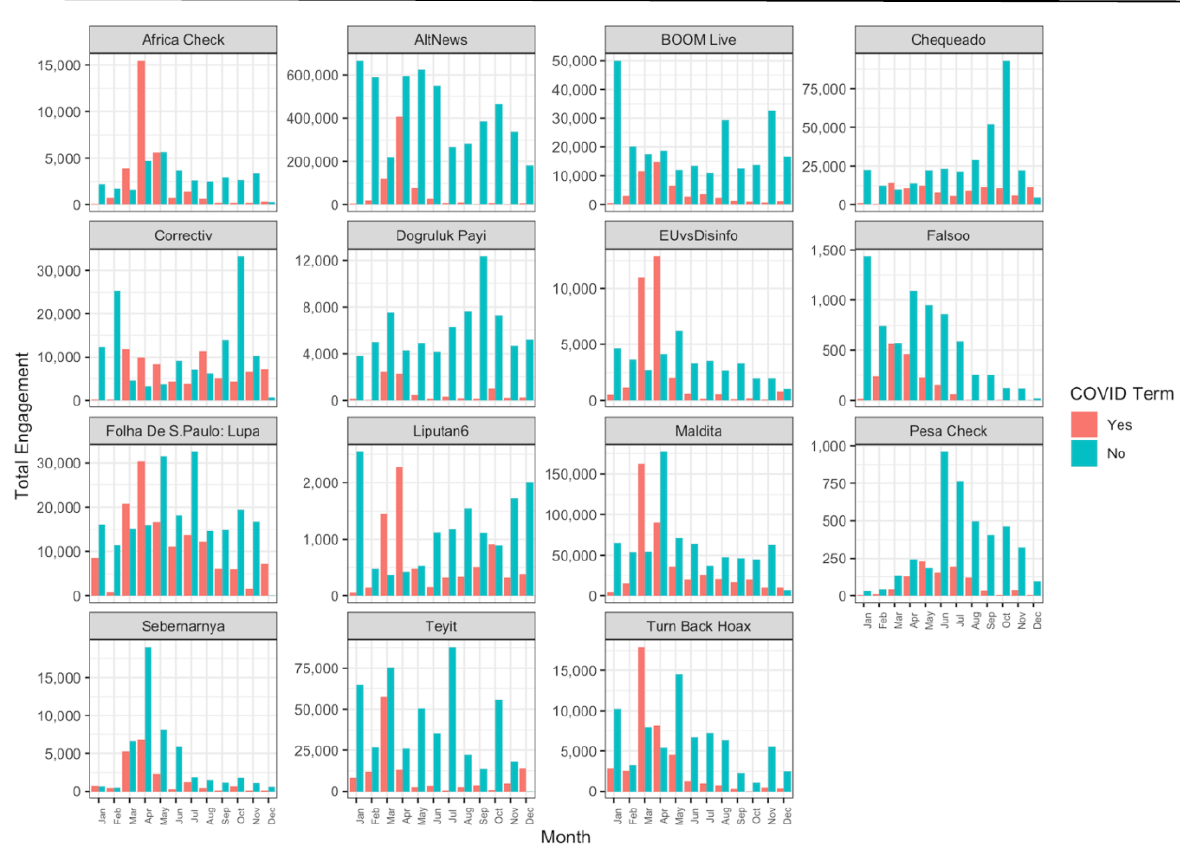
Figure 4. Distribution of the user engagement with coronavirus related and non-coronavirus related content. The total engagement by users for COVID content included engagement with posts that included a URL to a fact-checking website and at least one of the keywords related to COVID. Engagement with non-COVID content included engagement with posts that included a URL to a fact-checking website, but no keywords related to COVID.